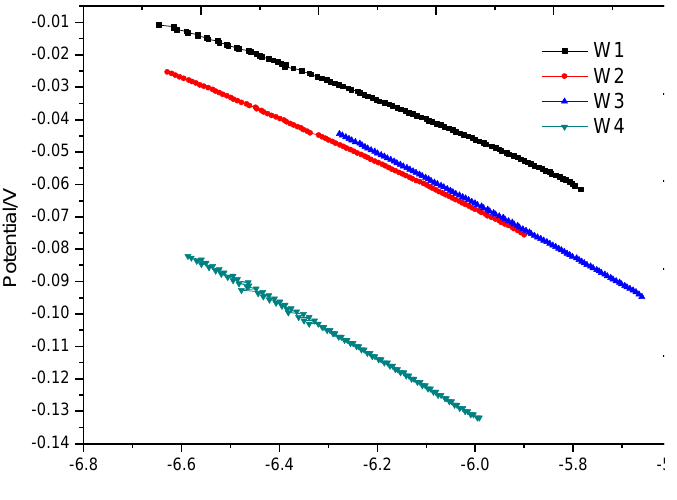
Figure 12. Anodic polarization curve for each monitoring point after first wetting cycle.